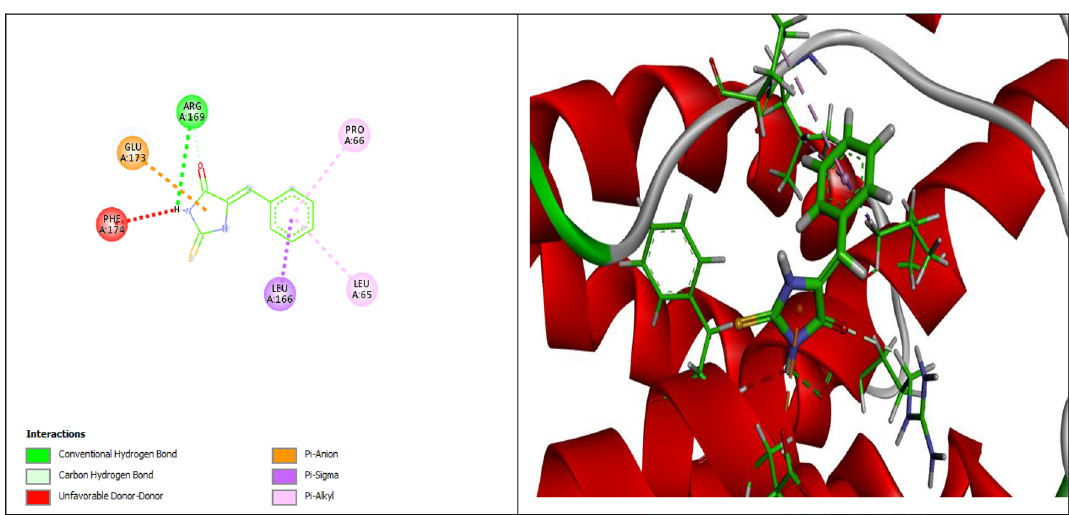
Figure 8. 2D and 3D representation of the interaction of 5B2T with IL-6 (PDB ID: 1IL6). and endothelial mitochondria also TNF-α disrupt the electron transport chain in the mitochondrion complex beside stimulation of nuclear factor-kappa beta activation and up regulation of IL-6 expression 28